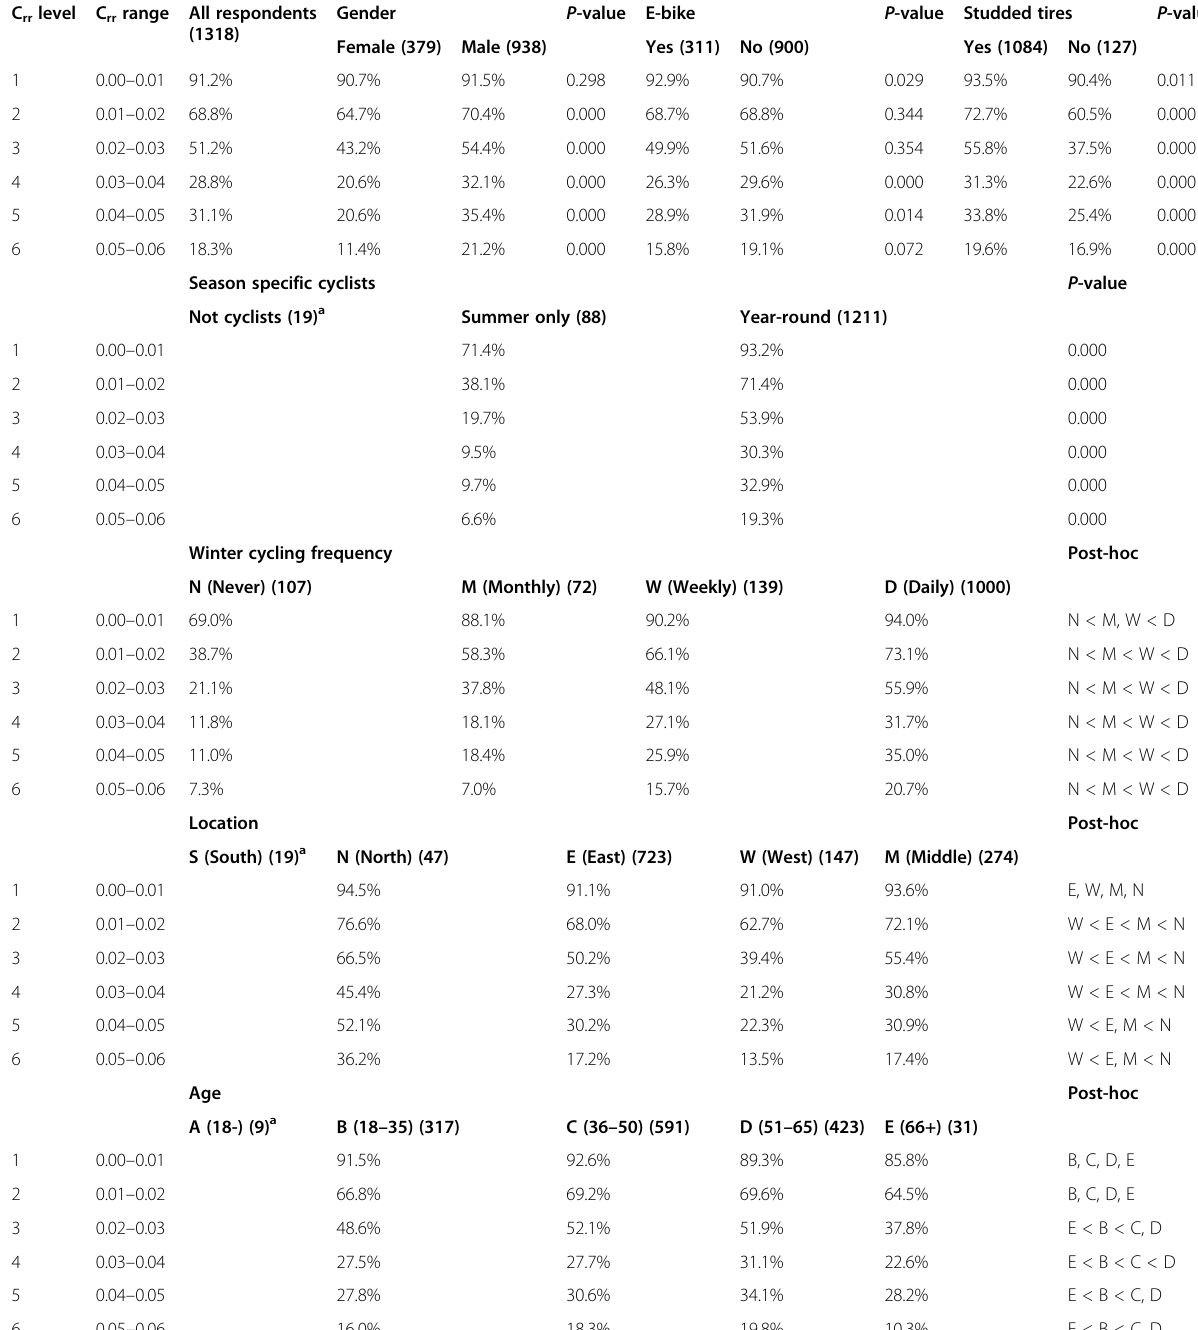
Table 3 Cycling willingness index (CWI) for the different coefficient of rolling resistance (C rr ) ranges. P -value representing the difference between answer distribution for opposite groups. Post-hoc indicates significant differences between answer distribution for multiple